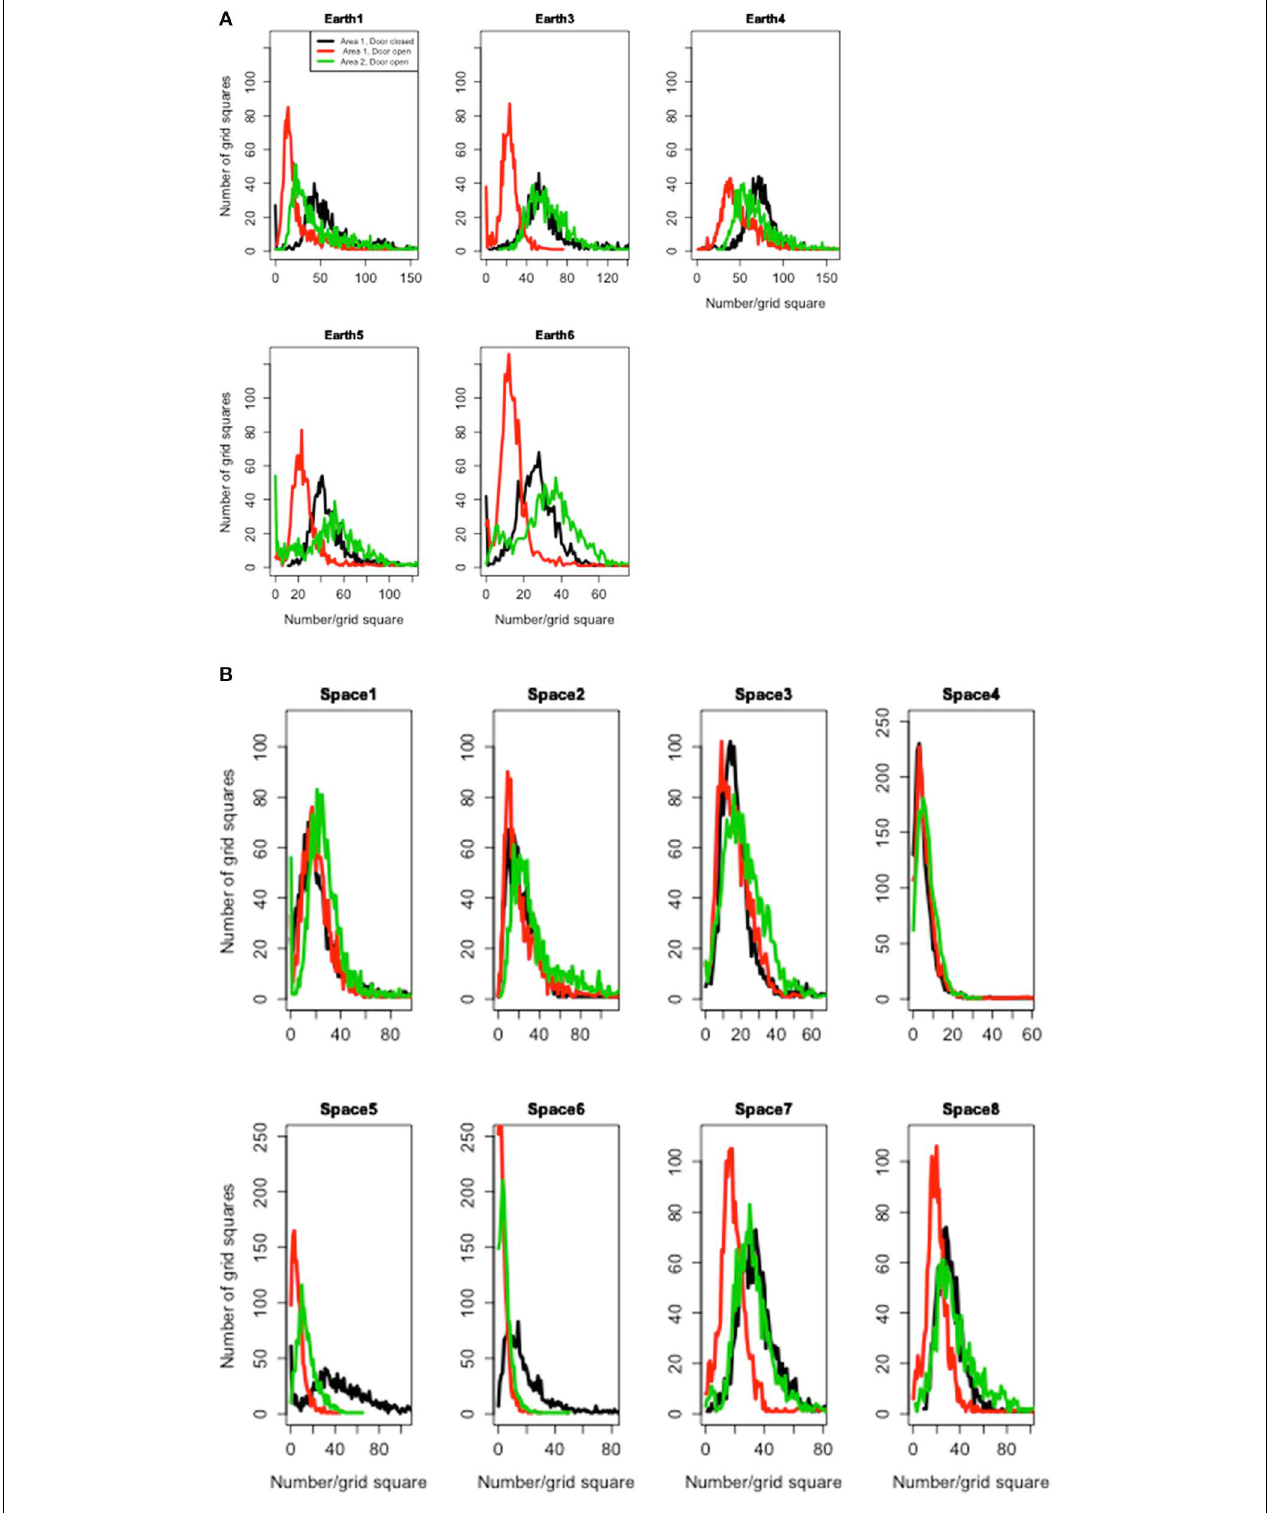
FIGURE 4 | Thoroughness of search as the search area expanded. (A) Earth. (B) Space. Each curve shows the frequency distribution of number of ants per large grid square (9.2 by 9.2mm). Black, Area 1 with barrier closed; Red, Area 1 with barrier open; Green, Area 2 after barrier was opened.